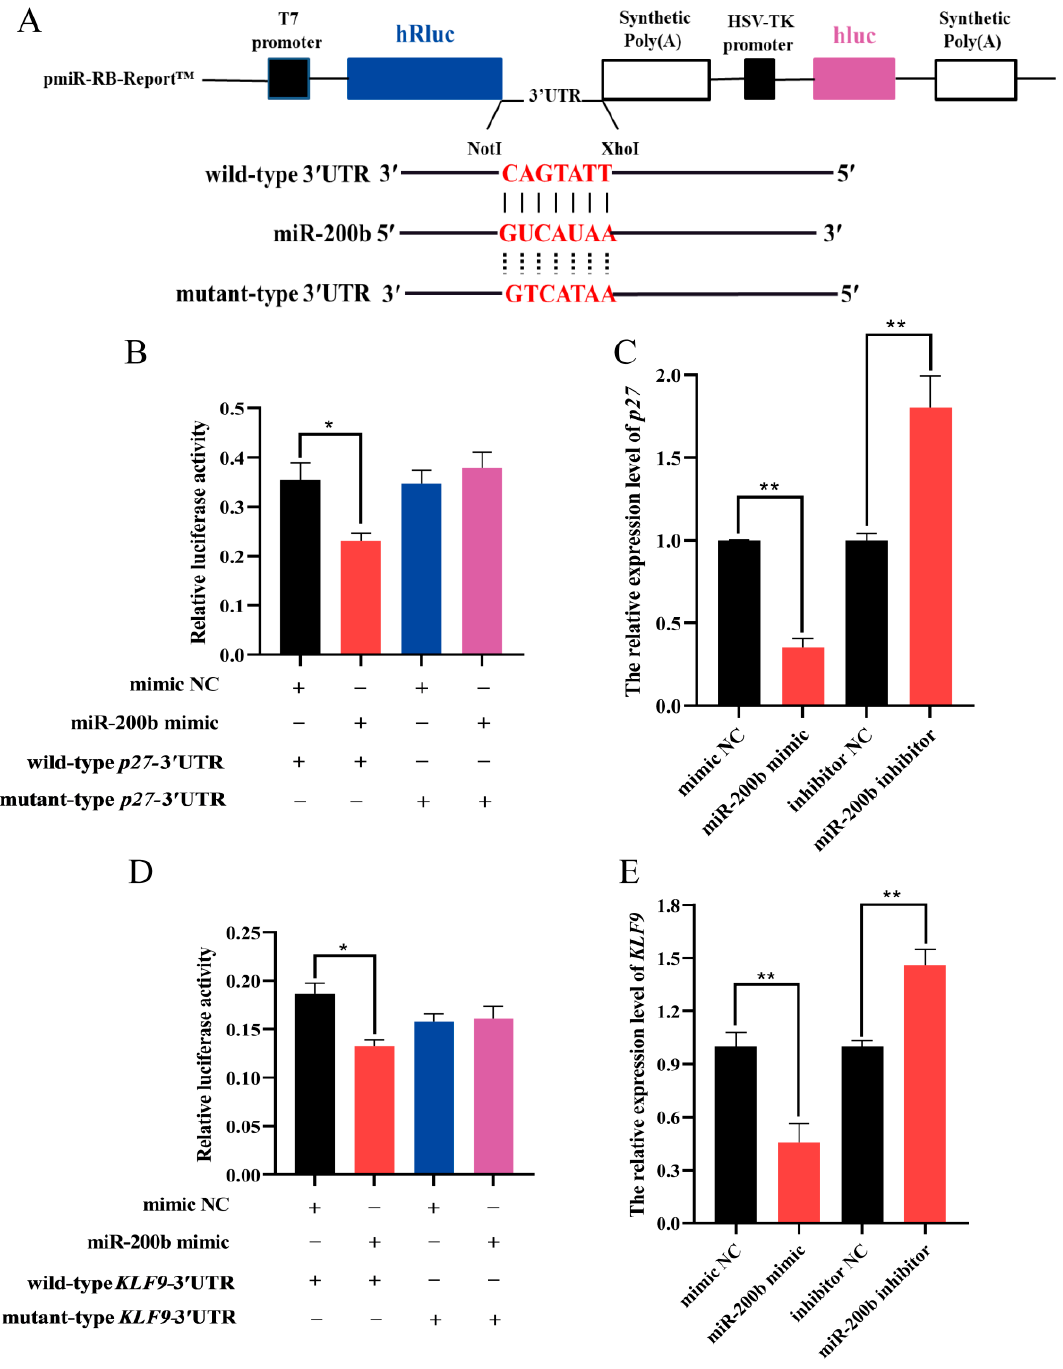
Figure 6. The miR-200b targets p27 and KLF9 in ovine preadipocytes. ( A ) The structural diagram of wild-type and mutant- type dual luciferase reporter vectors. ( B , D ) The luciferase activity was analyzed when miR-200b mimic, NC and wild-type or mutant-type dual luciferase reporter vectors were co-transfected into HEK293 cells. ( C ) The expression level of p27 was detected in preadipocytes on day 2 after the transfection of miR-200b mimic, miR-200b inhibitor, and NC. ( E ) The expression level of KLF9 in adipocytes on day 8 after transfecting with miR-200b mimic, miR-200b inhibitor, and NC. The values represent mean ± SD ( n = 3), * p < 0.05, ** p < 0.01.